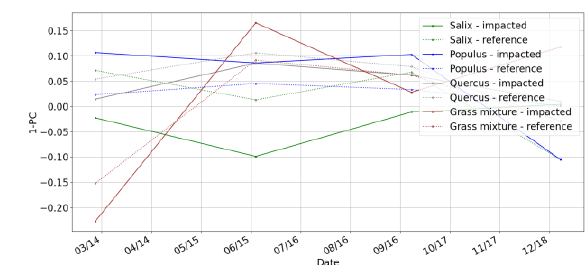
Figure 5 . Seasonal evolution of the first principal component for Salix, Populus, Quercus and Grass